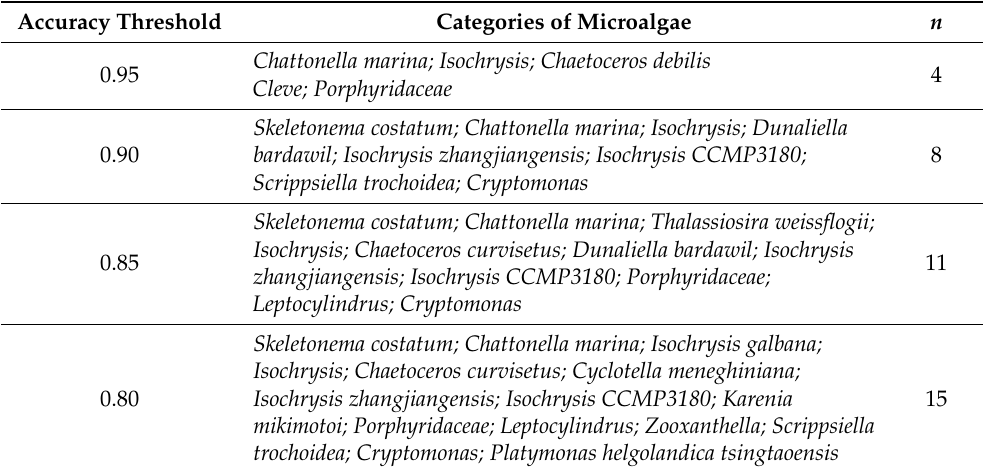
Table 4. Classification results using SVM by one versus one (OVO).